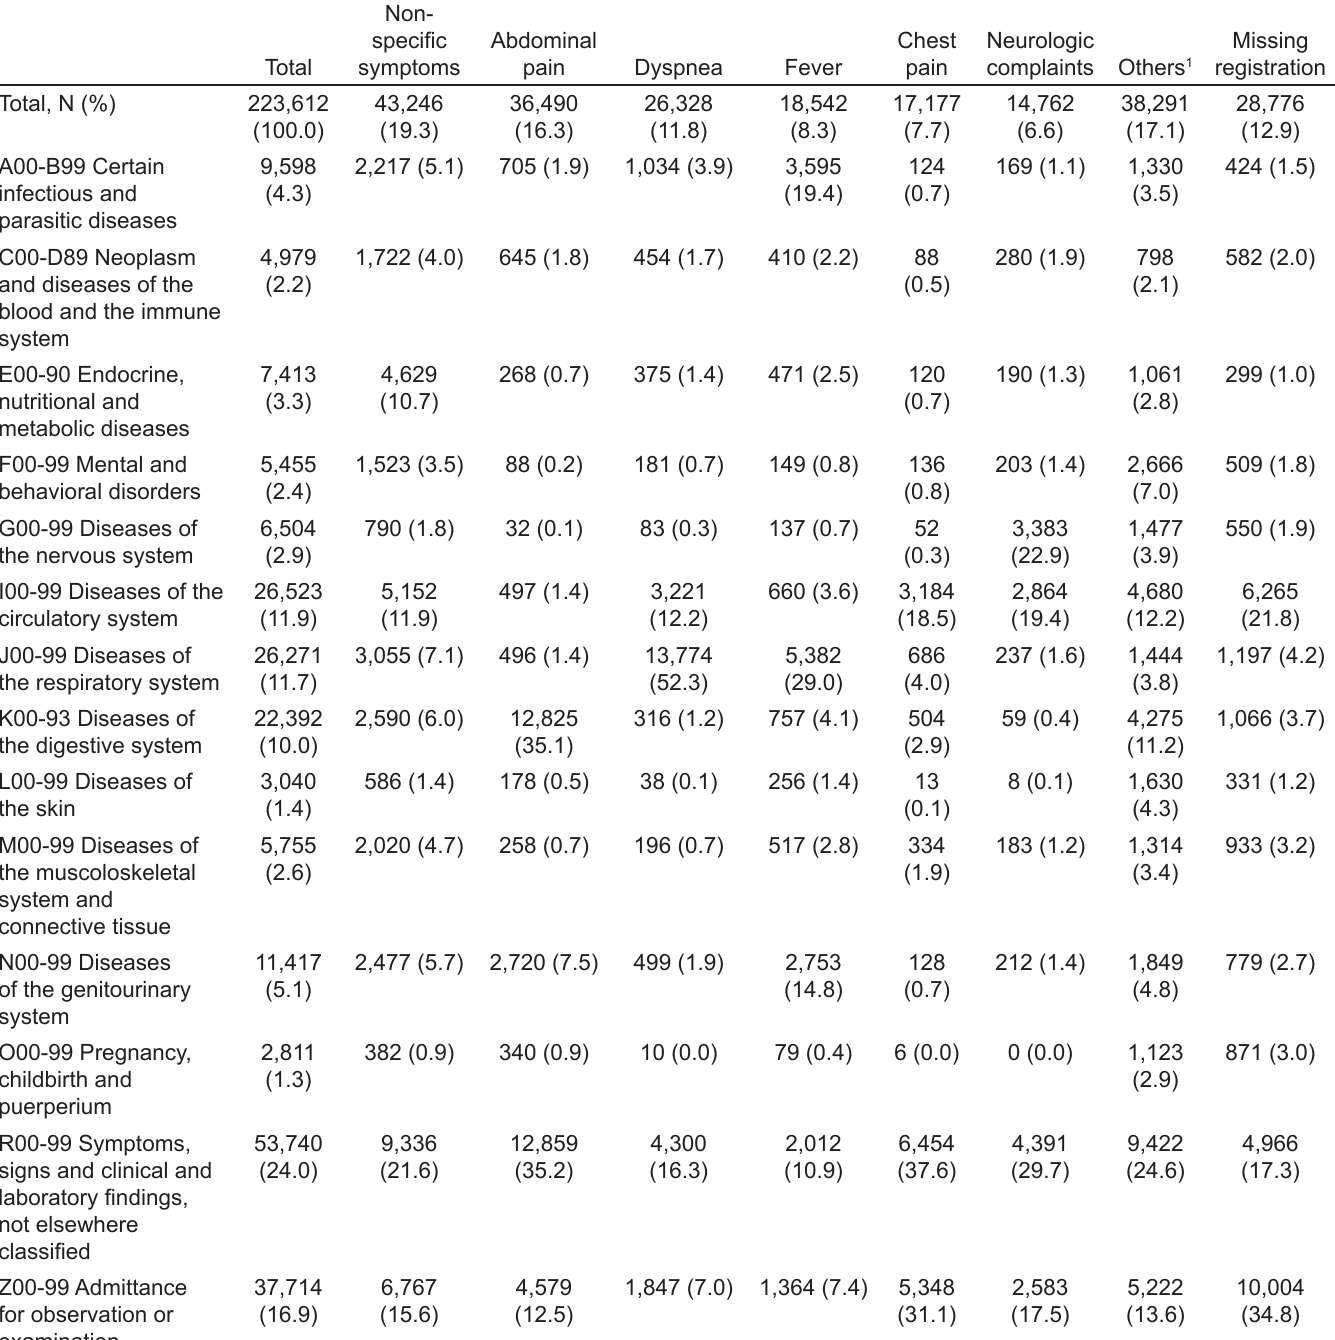
Table 2. Distribution of discharge diagnoses according to the major groups of the International Classification of Diseases, 10th Rev., allocated between the most common symptoms for adult, non-trauma, emergency de-partment patients arriving at a hospital in the Region of Southern Denmark between